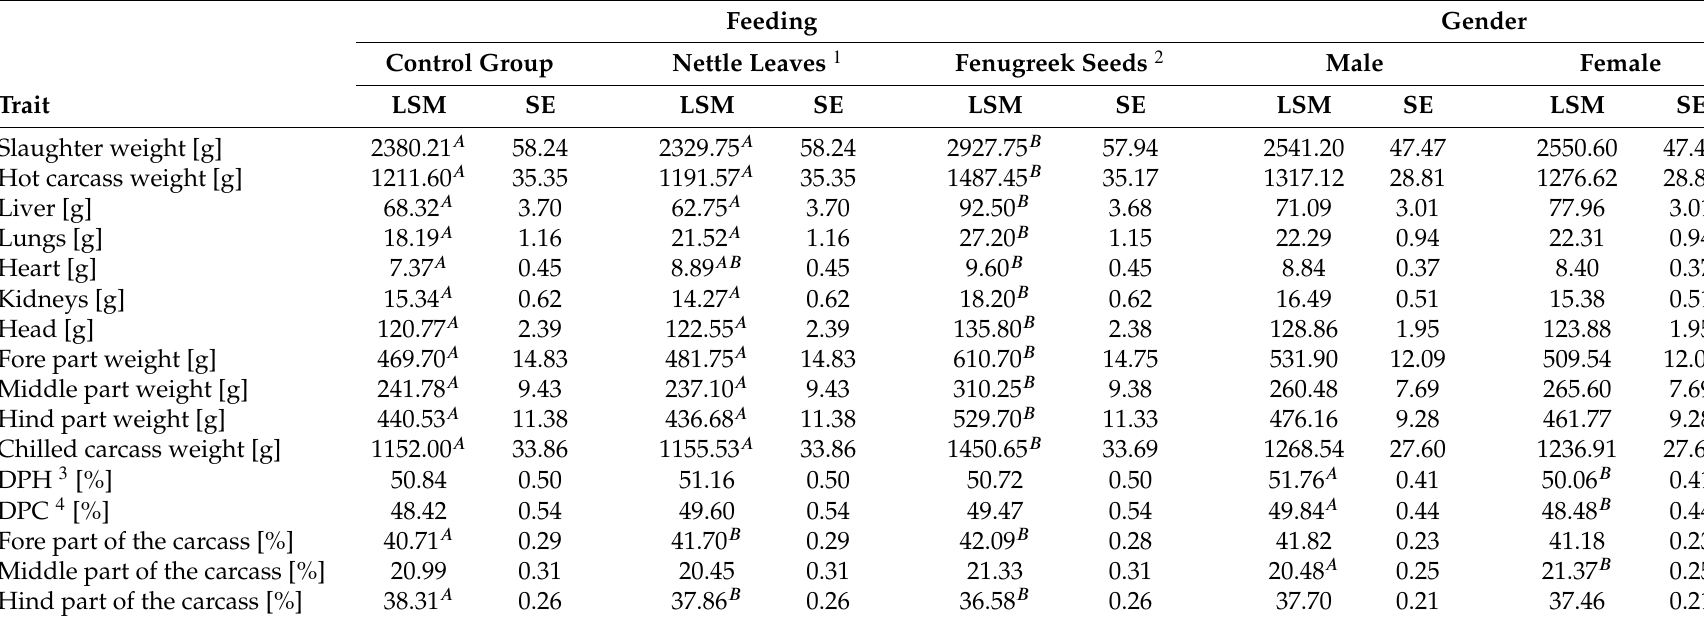
Table 2. Least square means (LSM) with standard errors (SE) of post-slaughter traits, by feeding or gender. Feeding Gender Fenugreek Seeds